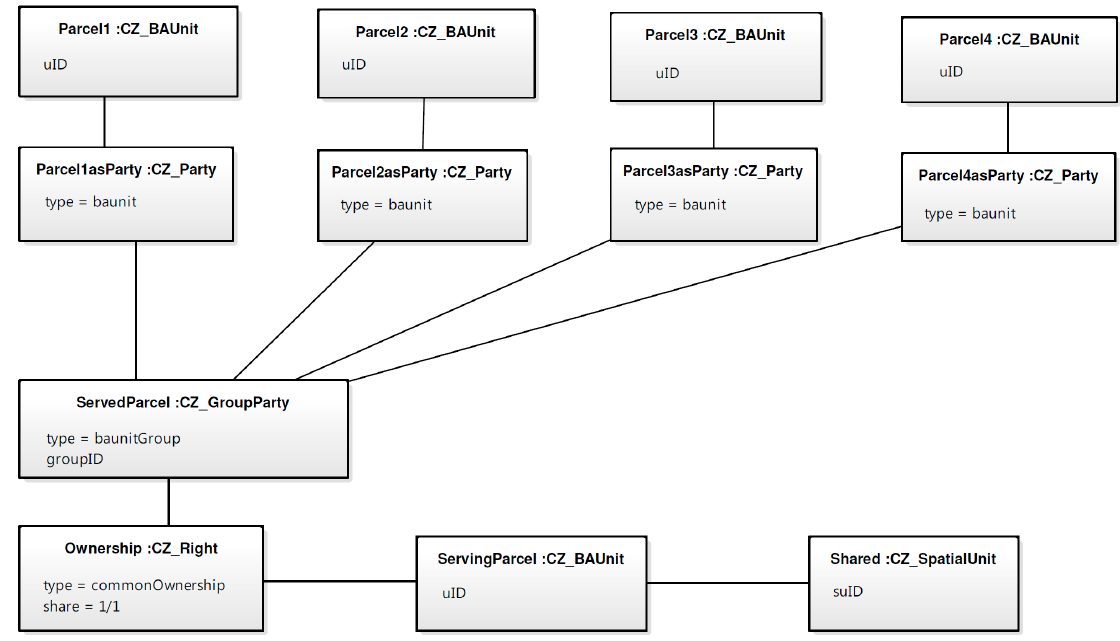
Figure 6. An example of a serving parcel owned by neighbors.